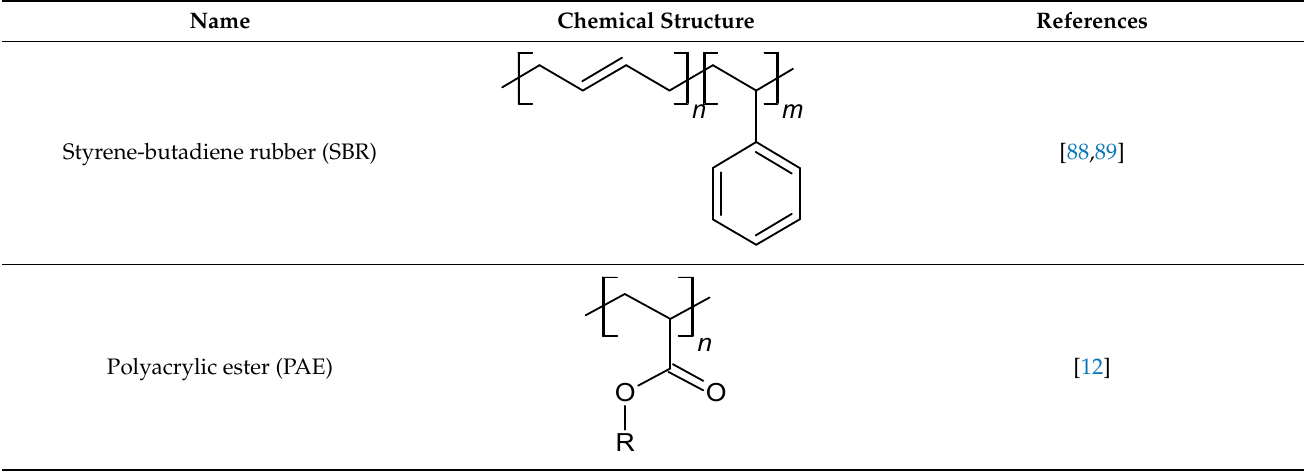
Table 2. The chemical structure of polymers.